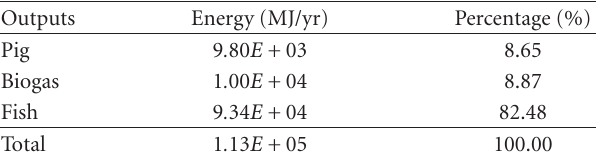
Table 1: The output of the “pig-biogas-fish” system. Outputs Energy (MJ/yr) Pig